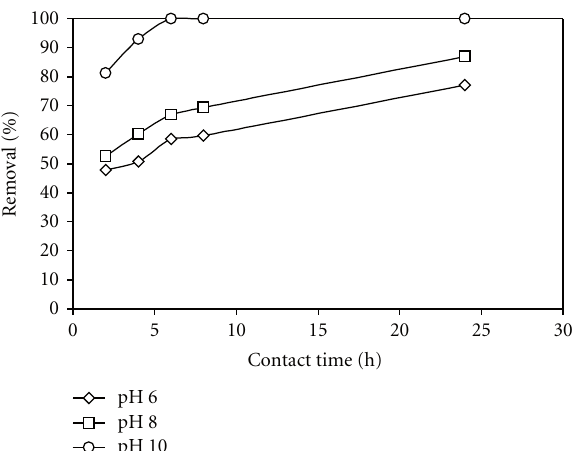
F 8: Acidic dye adsorption capacity of PC-N as a function of pH (adsorbent dosage, 500 mg per 100 mL dye concentrations, ). 50mg L −1